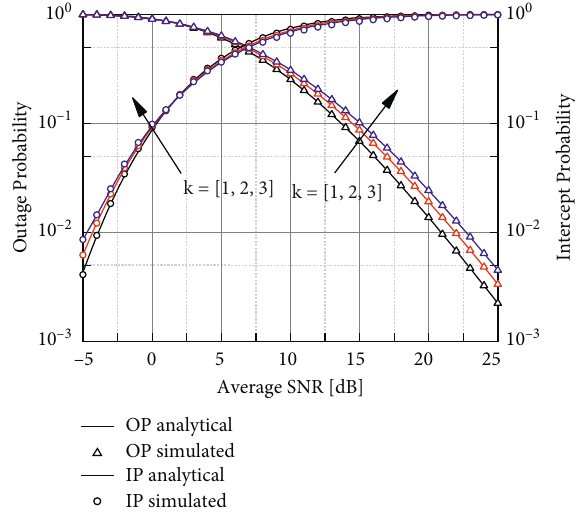
Figure 3: OP and IP versus average SNR for various values of κ